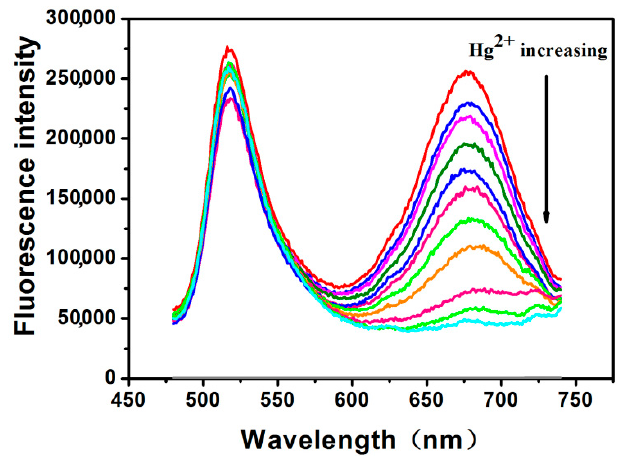
Figure 6. The FL spectra of RFN under different mercury concentrations (1 × 10 − 10 , 2.5 × 10 − 10 , 5 × 10 − 10 , 7.5 × 10 − 10 , 1 × 10 − 9 , 2 × 10 − 9 , 2.5 × 10 − 9 , 3.5 × 10 − 9 , 5 × 10 − 9 ,7.5 × 10 − 9 , 1 × 10 − 8 mol/L) ( λ ex = 380 nm).